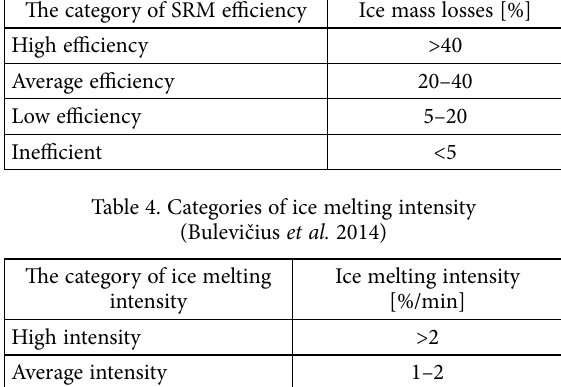
Table 3. Categories of SRM efficiency (Bulevičius et al. 2014)